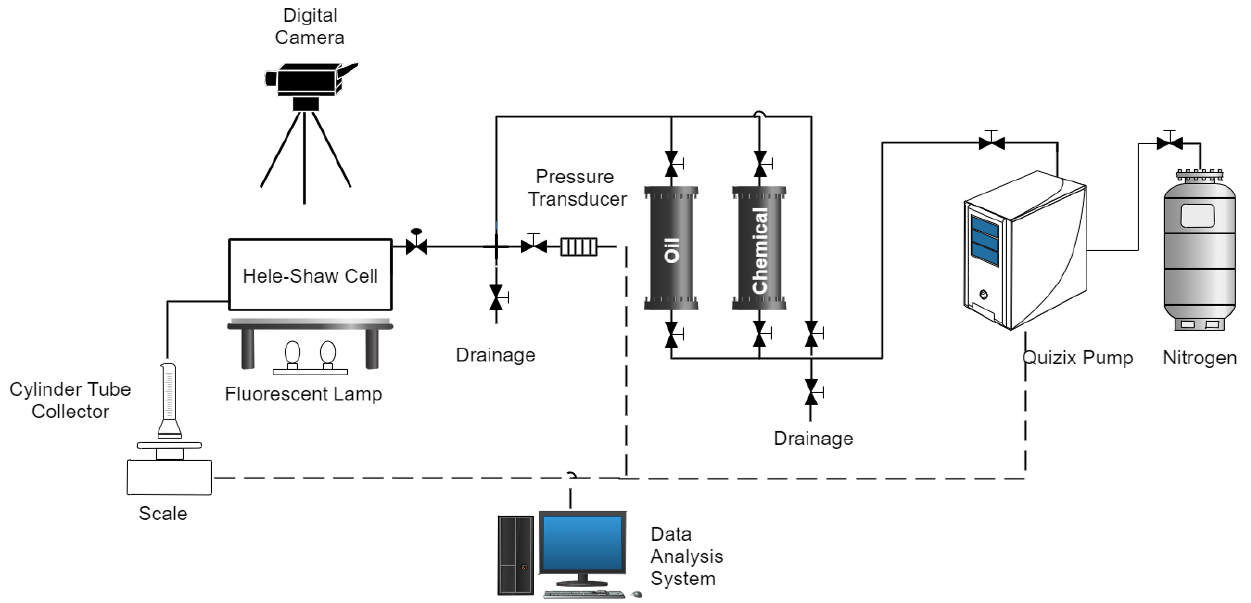
Figure 1. Schematic of the Hele-Shaw displacement experiments. The Hele-Shaw cell was constructed from Plexiglas and a Teflon gasket with a thick- ness of 0.0397 cm and was used to set a gap between the two plates of the cell. The thickness of the gasket was selected to be approximately the size of a sand particle. Figure 2 shows the top and side view of the cell. The bolts were tightened in a cross pattern with a torque of 4.07 N-m (36 lb.-in). Six ports were drilled on the side of the upper plate, however just two were used as injection (top right corner) and production (bottom left corner) ports. The oil and aqueous chemicals were injected at a constant flow rate using a dual-cylinder Quizix pump through the injection port and were produced by the production port at atmospheric conditions. In this fashion, the displacement of fluids occurred diagonally across the cell. The Hele-Shaw cell was placed in a levelled stand where underneath there was a light source. The light allowed for the better visualization of the crude oil and the injected aqueous fluids. The pressure transducer, digital scale, and pump were connected to an automated data acquisition system which allowed for the logging of pressures, flow rates, and produced liquid